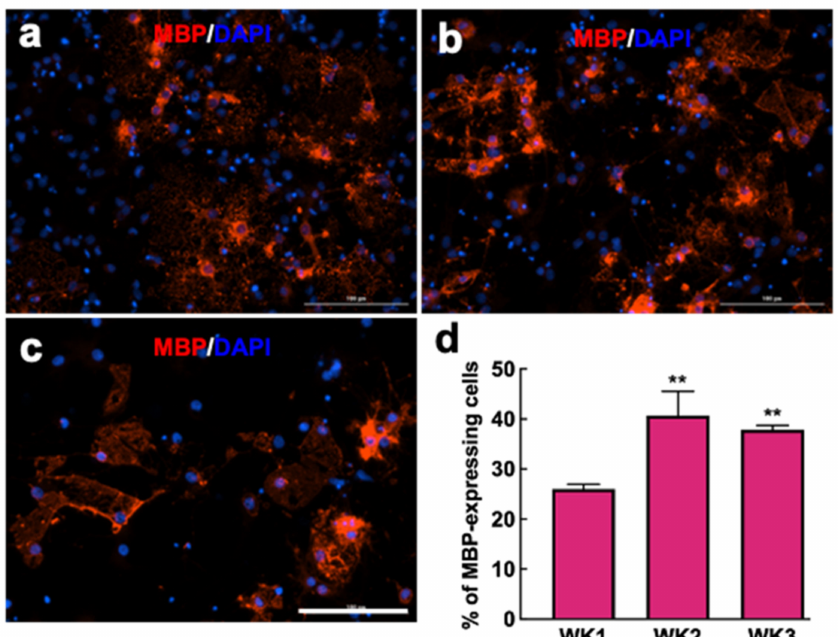
Figure 6. Evaluation of MBP expression by newly differentiated ODCs. Fluorescence images of NPCs differentiated on AuNR substrate at ( a ) week 1, ( b ) week 2, and ( c ) week 3 culture, stained for mature oligodendrocyte marker MBP. Scale bars: 100 µ m. ( d ) Quantitative comparison of the percentage of cells expressing MBP at various time points. Data show as mean ± SD; comparison by one-way ANOVA with Tukey post hoc analysis; ** p < 0.001 compared to week 1.